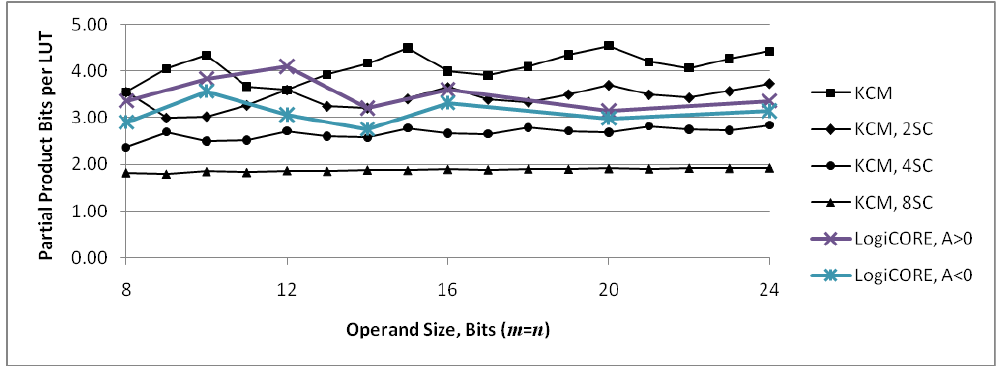
Figure 15. Number of partial product bits computed and summed per LUT6 for KCMs. Values for proposed KCMs are computed maximums, values for LogiCORE are from synthesized results.